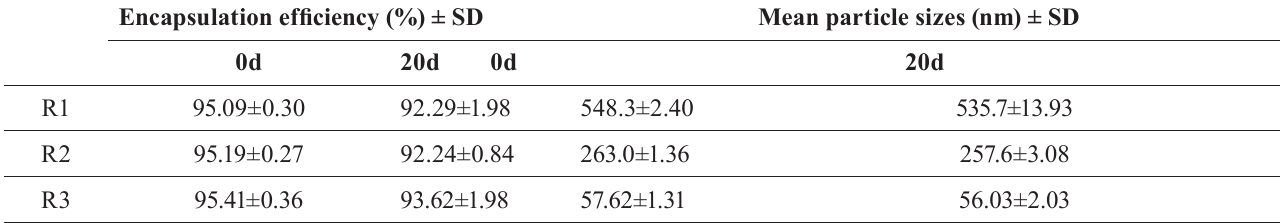
TABLE II - Encapsulation efficiency and particle size of the nanocrystals after 20 days at 4 ºC Encapsulation efficiency (%) ±